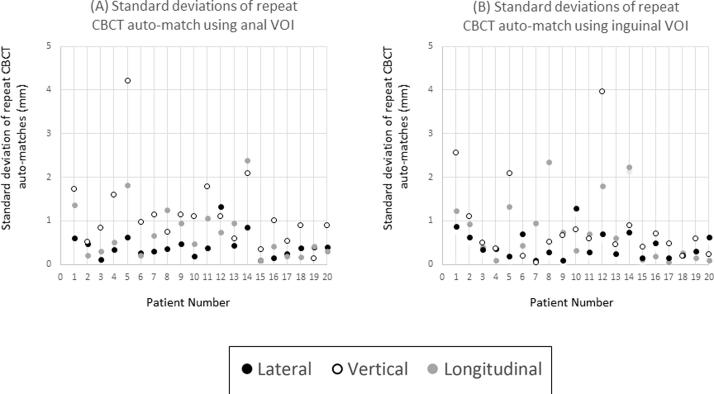
Scatter plots illustrating the standard deviation of 3 repeat auto-matches around the (A) anus VOI and (B) inguinal VOI.